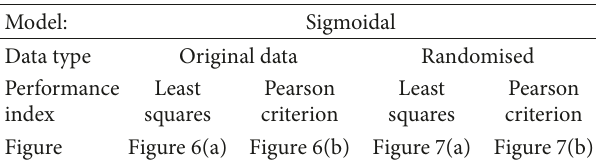
Table 2: Nested factorial design for sigmoidal model: field pH versus lab pH in 1: 5 water (pH F versus pH w